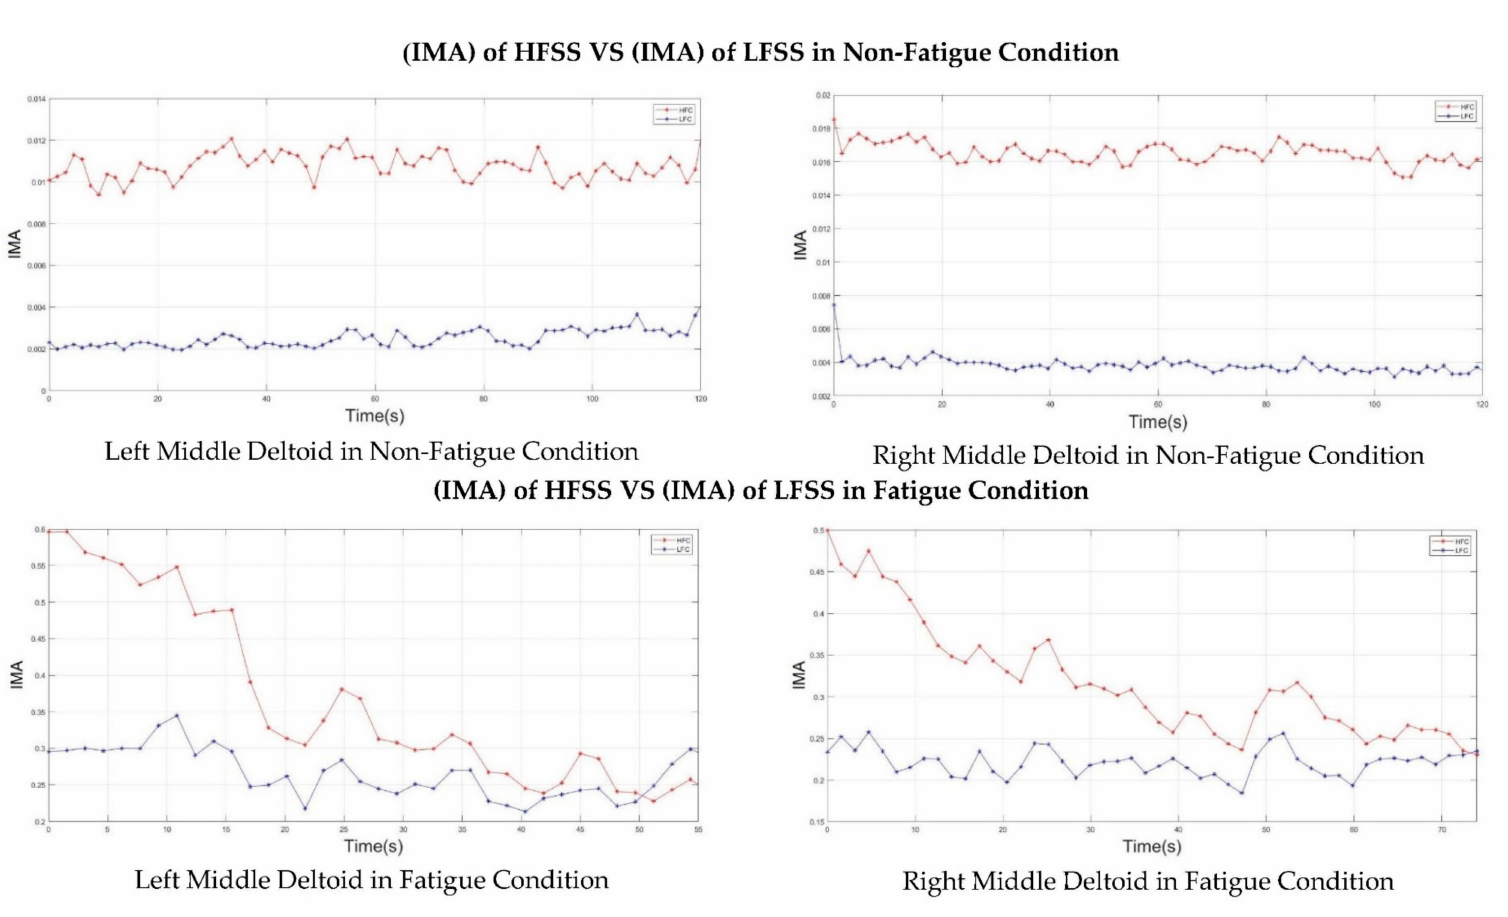
Figure 7. The IMA of the HFSS (red line) and LFSS (blue Line) of the middle deltoid muscle in non-fatigue condition ( top ) and in fatigue condition ( bottom